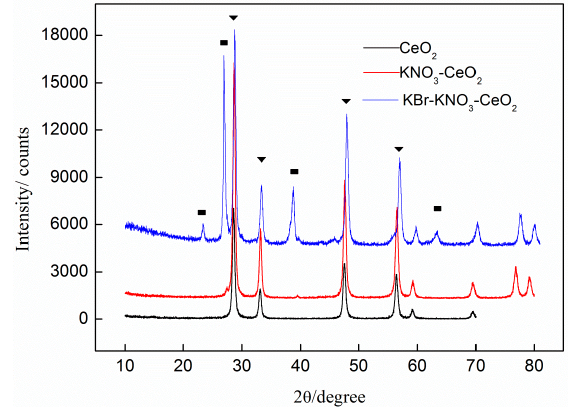
Figure 1. CO 2 ‐ temperature ‐ programmed desorption (TPD) analysis for the catalysts.